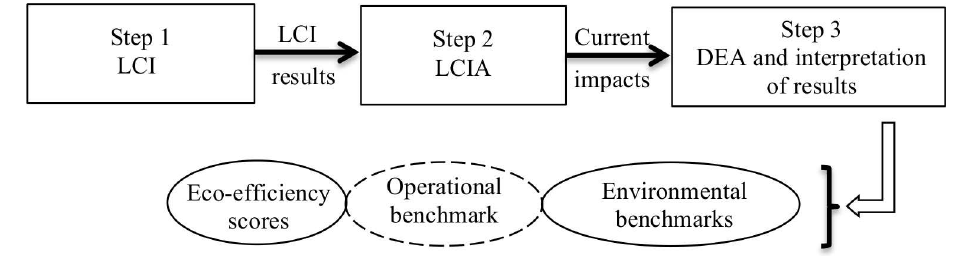
Figure 1. Schematic presentation of the three-step LCA+DEA methodology [12,13]. A characteristic feature of the three-step LCA+DEA methodology is that the output parameters of the previous step become the input parameters of the next step. There are, however, many arguments for such methodological proceedings. The first step forms the basis for the analysis by providing the appropriate inputs and outputs. The second step constitutes an environmental life cycle assessment of each studied manufacturing in- dustry. And finally, the third step allows for obtaining environmental benchmarks, without excluding the possibility of obtaining operational benchmarks simultaneously.